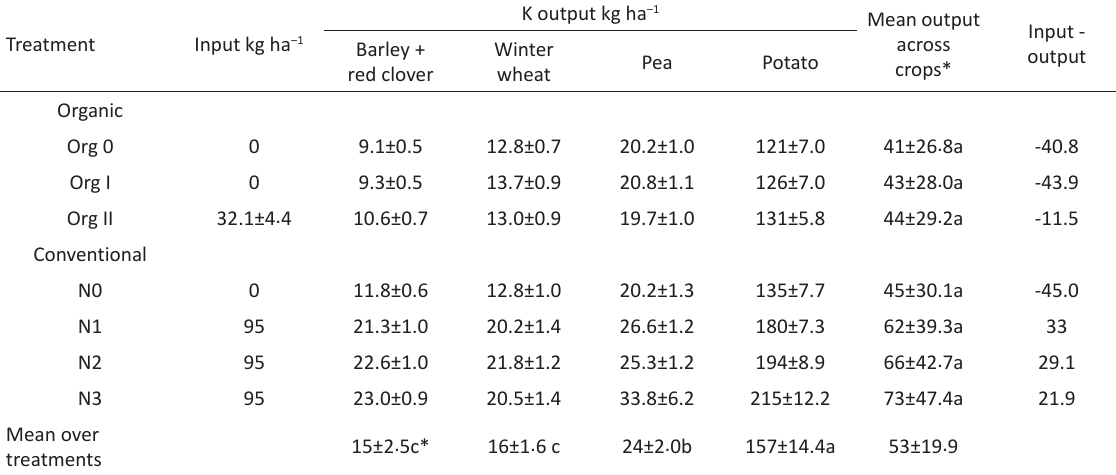
Table 5. Mean amount of K (kg ha –1 ) applied and removed by different crop yields from different treatments annually and input/ output balance in the soil as an average of ten years